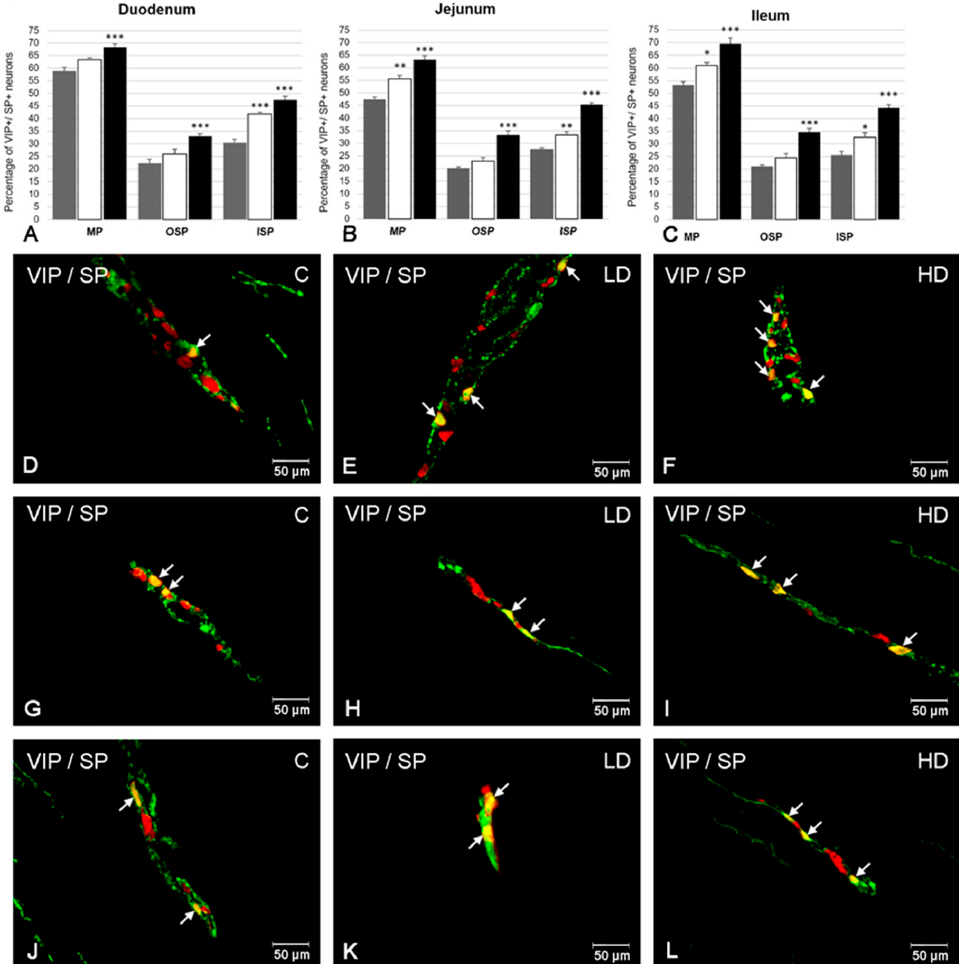
Figure 3. The ratio of co-localization of VIP with SP in intramural neurons in each part of the porcine small intestine (duodenum, jejunum, and ileum) in control animals (grey bars), after low (white bars) and high doses (black bars) of acrylamide supplementation ( A – C ) and the most representative images showing VIP-LI neurons simultaneously immunoreactive to substance P (SP) in animals from control ( D , G , J ), LD ( E , H , K ), HD ( F , I , L ) group. ( A ) Mean ( ± SEM) percentage of VIP +/ SP + neurons in the myenteric plexus (MP), outer submucous plexus (OSP), and inner submucous plexus (ISP) within the porcine duodenum; ( B ) Mean ( ± SEM) percentage of VIP +/ SP + neurons in the myenteric plexus (MP), outer submucous plexus (OSP), and inner submucous plexus (ISP) within the porcine jejunum; ( C ) Mean ( ± SEM) percentage of VIP +/ SP + neurons in the myenteric plexus (MP), outer submucous plexus (OSP), and inner submucous plexus (ISP) within the porcine ileum; ( D ) VIP +/ SP + neurons in the myenteric plexus of the porcine jejunum in animals from control group; ( E ) VIP +/ SP + neurons in the myenteric plexus of the porcine jejunum in animals from LD group; ( F ) VIP +/ SP + neurons in the myenteric plexus of the porcine jejunum in animals from HD group; ( G ) VIP +/ SP + neurons in the outer submucous plexus (OSP) of the porcine duodenum in animals from control group; ( H ) VIP +/ SP + neurons in the outer submucous plexus (OSP) of the porcine duodenum in animals from LD group; ( I ) VIP +/ SP + neurons in the outer submucous plexus (OSP) of the porcine duodenum in animals from HD group; ( J ) VIP +/ SP + neurons in the inner submucous plexus (ISP) of the porcine duodenum in animals from control group; ( K ) VIP +/ SP + neurons in the inner submucous plexus (ISP) of the porcine duodenum in animals from LD group; ( L ) VIP +/ SP + neurons in the inner submucous plexus (ISP) of the porcine duodenum in animals from HD group. All images were created by digital superimposition of two color channels (green for VIP and red for SP). Intramural neurons immunopositive to VIP and SP are indicated with arrows. Significant di ff erences were assessed with one-way analysis of variance (ANOVA) with Dunnett’s test (* p < 0.05, ** p < 0.01, *** p <